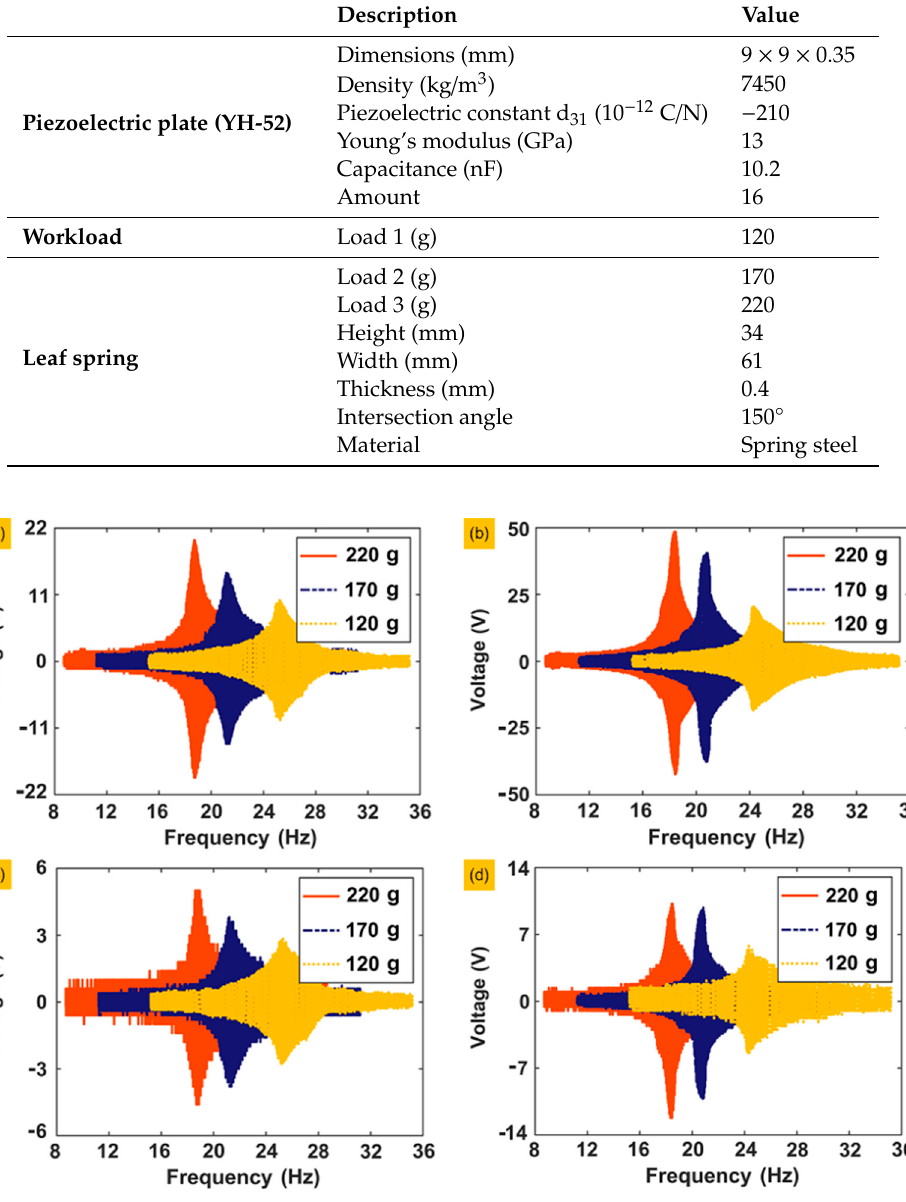
Figure 5. Voltage responses of frequency sweeping: ( a ). Voltage responses of piezoelectric layer number 1, with acceleration of 0.1 g under different masses. ( b ). Voltage responses of piezoelectric layer number 1, with acceleration of 0.2 g under different masses. ( c ). Voltage responses of piezoelectric layer number 3, with acceleration of 0.1 g under different masses. ( d ). Voltage responses of piezoelectric layer number 3, with acceleration of 0.2 g under different masses.